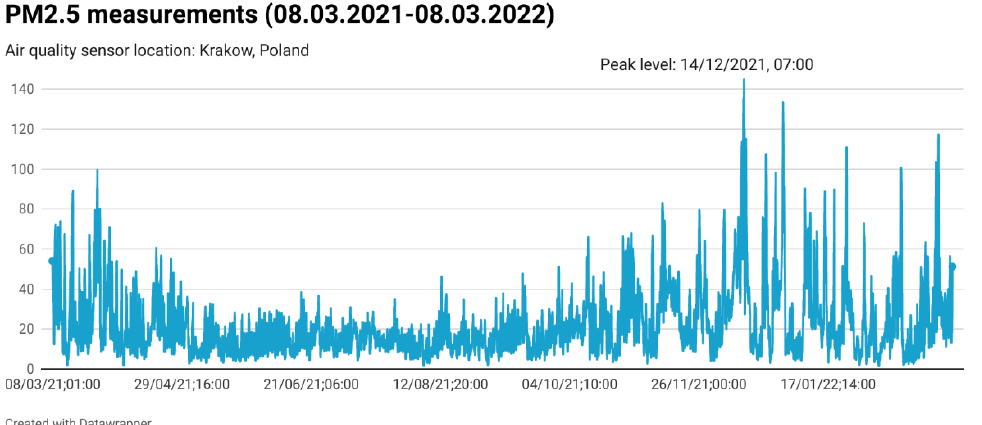
Figure 10. The trend of PM2.5 in Krakow during 8 March 2021 (02:00)–8 March 2022 (03:00). Source of data: Poland’s Chief Inspectorate For Environmental Protection (http://powietrze.gios.gov.pl/pjp/home (accessed on 9 March 2022)). Authors’ representation in Da- tawrapper.